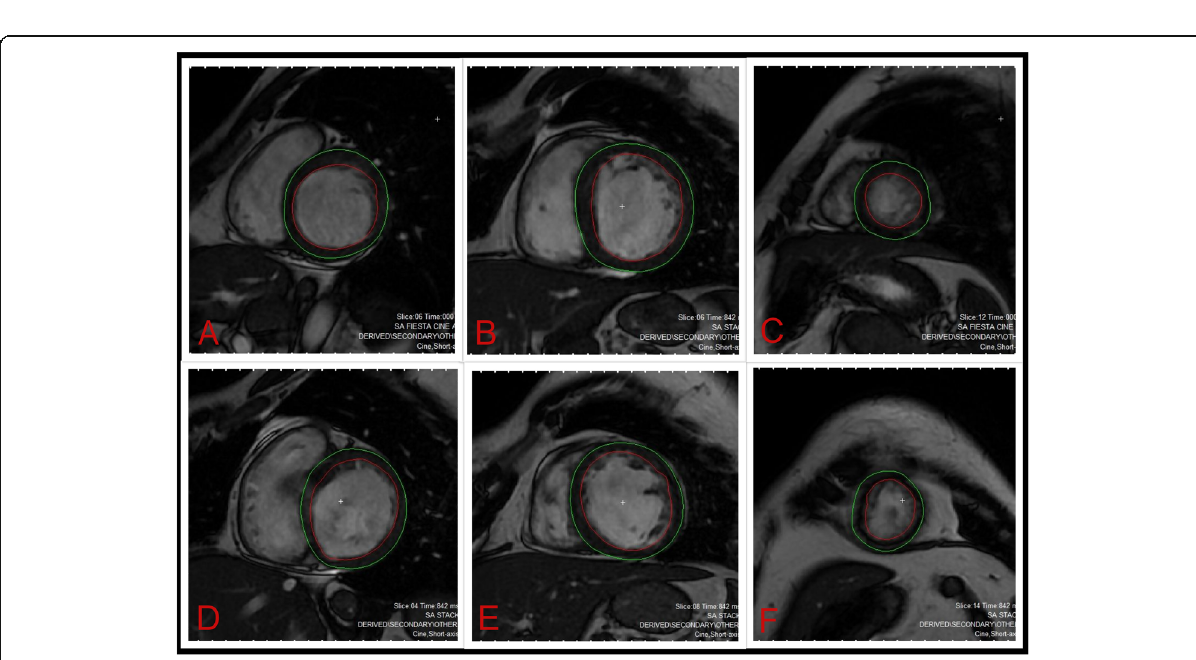
Fig. 9 Represent LV functional post-processing for the SSFP cine images taken for the previous patient; the endocardial (red) and epicardial borders (green) are manually delineated to obtain LV volumes, mass, and EF. a – c Basal, mid, and apical cuts at the baseline scan, calculated EF% was 35%. d – f Basal, mid, and apical cuts for the same patient acquired at the follow-up scan, calculated EF% was